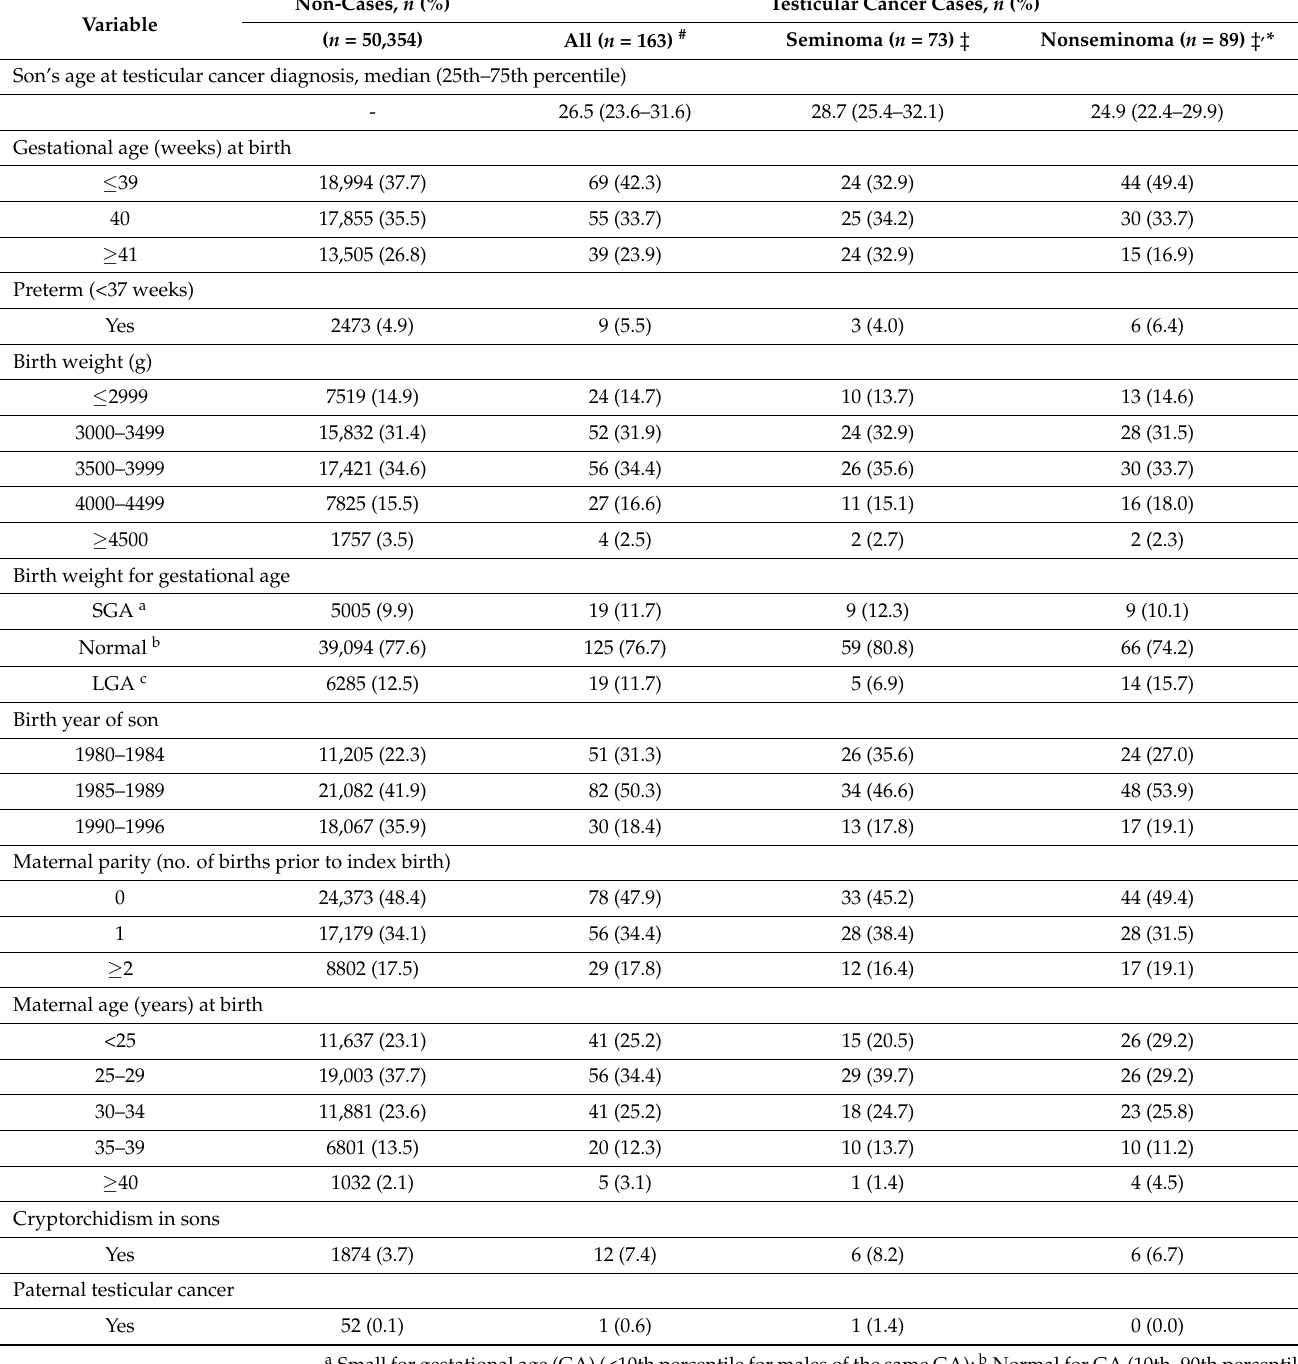
Table 1. Distribution of factors characterizing the cohort of 50,519 Danish singleton males and their mothers who participated in a maternal second trimester serum α -fetoprotein (AFP) screening program between 1980 and